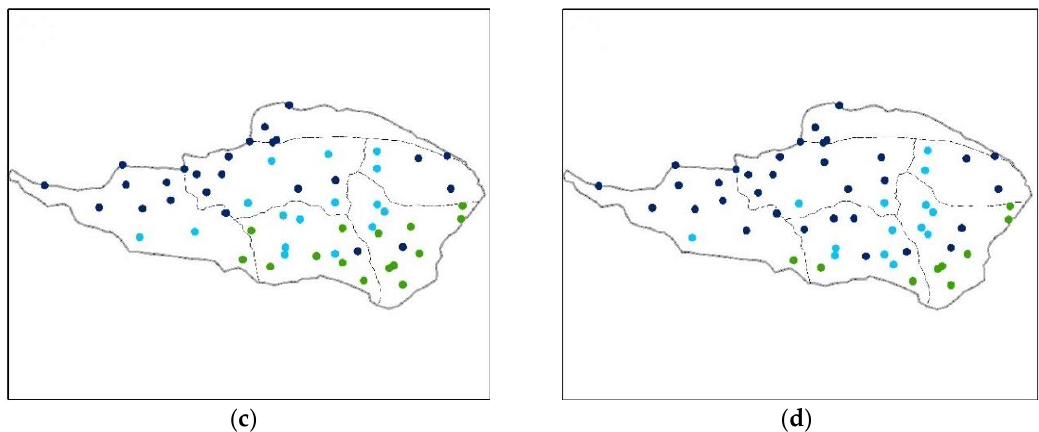
Figure 7. The spatial distribution and some representatives of the MWS showing groundwater responses ( p < 0.05) during the period 1980–2017: ( ● ) declining trend significantly; ( ● ) declining trend; and ( ● ) declining trend slightly. ( a ) Wet phase 1980–1984; Location of the typical MWS (#41265020, #41165500, #41165660) ( b ) Normal and Dry phases 1985–1996, 1997–2002; ( c ) Wet phase 2003–2011; and